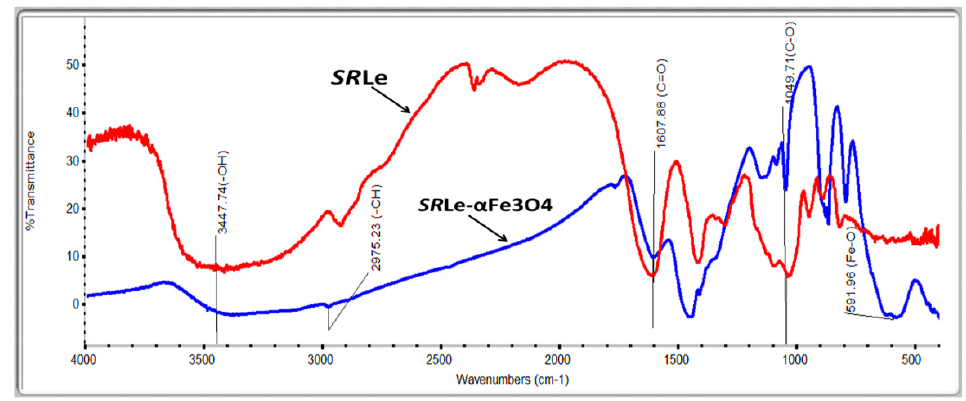
Figure 6. FTIR spectra of SRL extract and SRLe - α Fe 2 O 3 green synthesis.